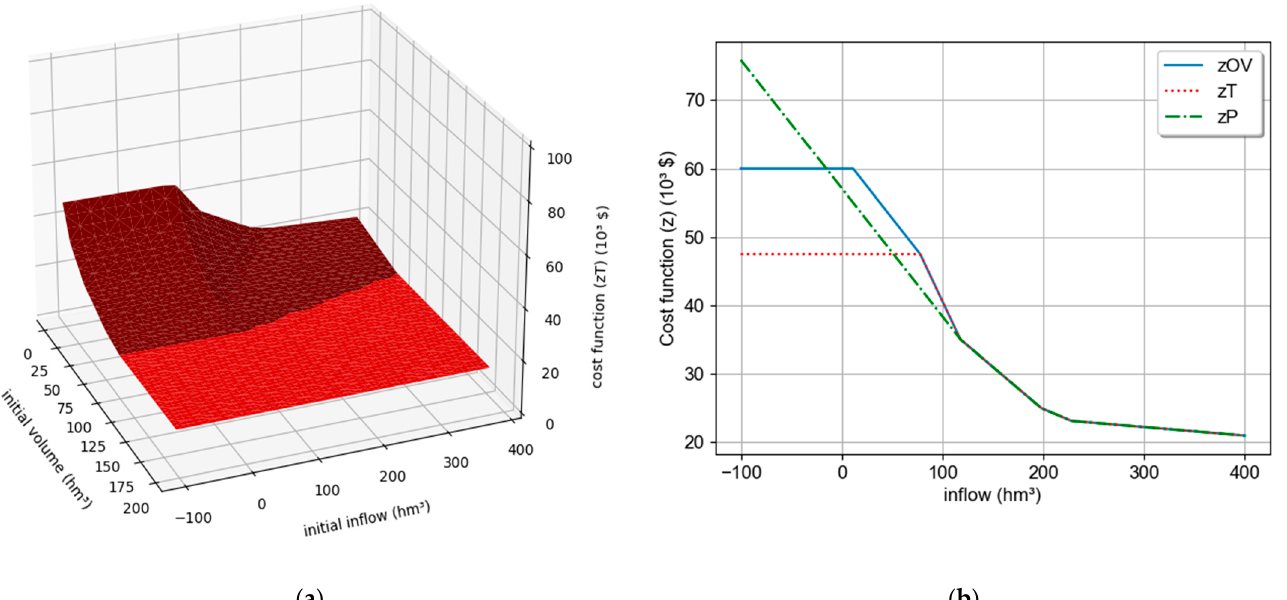
Figure 7. ( a ) Cost function (zT) (10 3 $) per inflow (hm 3 ) by the truncation approach. ( b ) Comparison between the cost function (z) (10 3 $) by the optimal value approach (solid blue), truncation approach (dotted red), and penalty approach (dash and dot green).